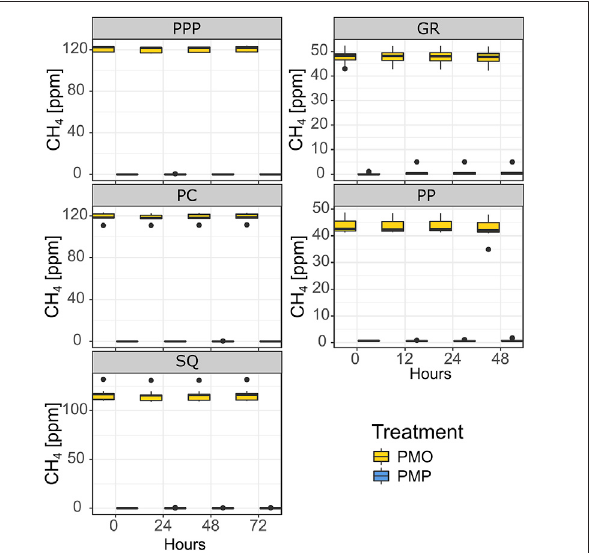
FIGURE5| Snagtreecore(bothheightscombined)CH 4 concentrations during incubation experiments. Potential Methane Oxidation — PMO; Potential Methane Production — PMP. GR and PP were incubated in June while PPP, PC, and SQ were incubated in July. Solid line represents median, whiskers represent 5th and 95th